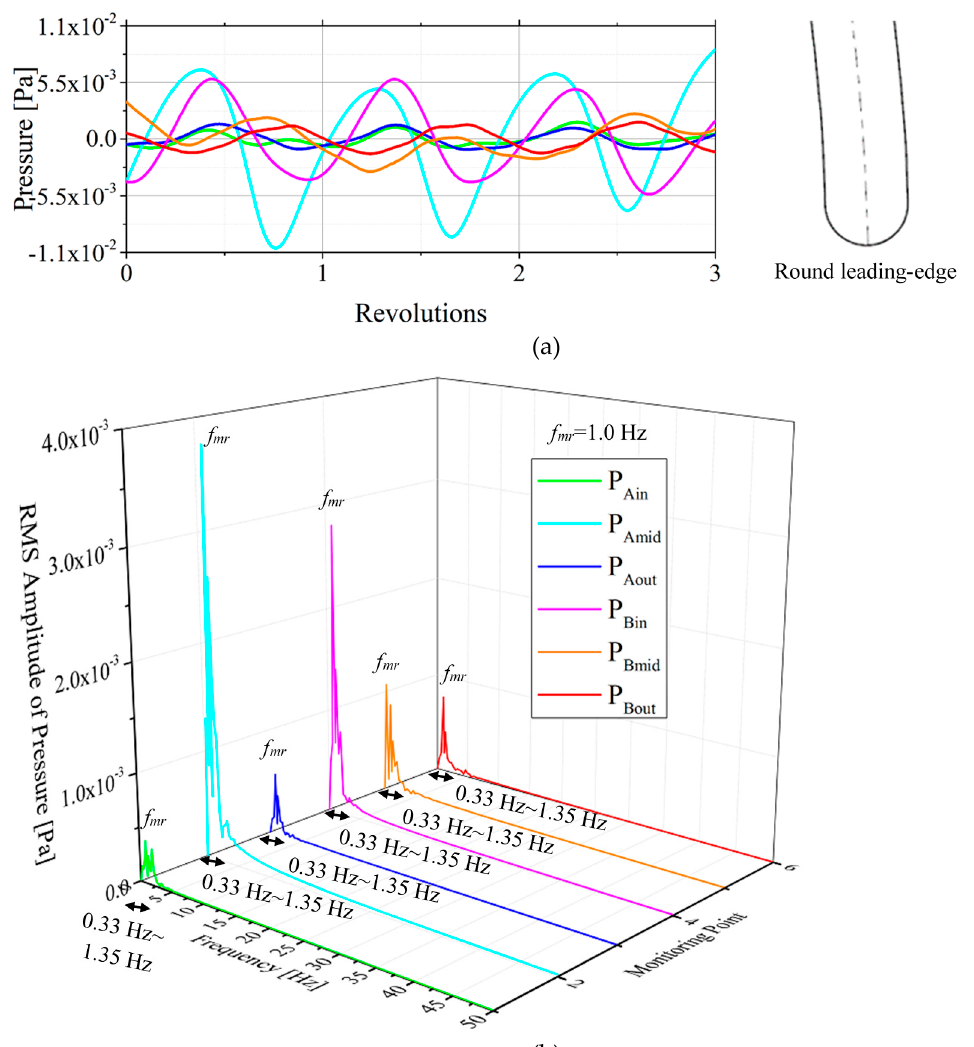
Figure 18. Pressure pulsation in the round leading-edge impeller: ( a ) time-domain plot (three revolutions); ( b ) frequency-domain plot, monitor points (1) P Ain , (2) P Amid , (3) P Aout , (4) P Bin , (5) P Bmid , and (6) P Bout.